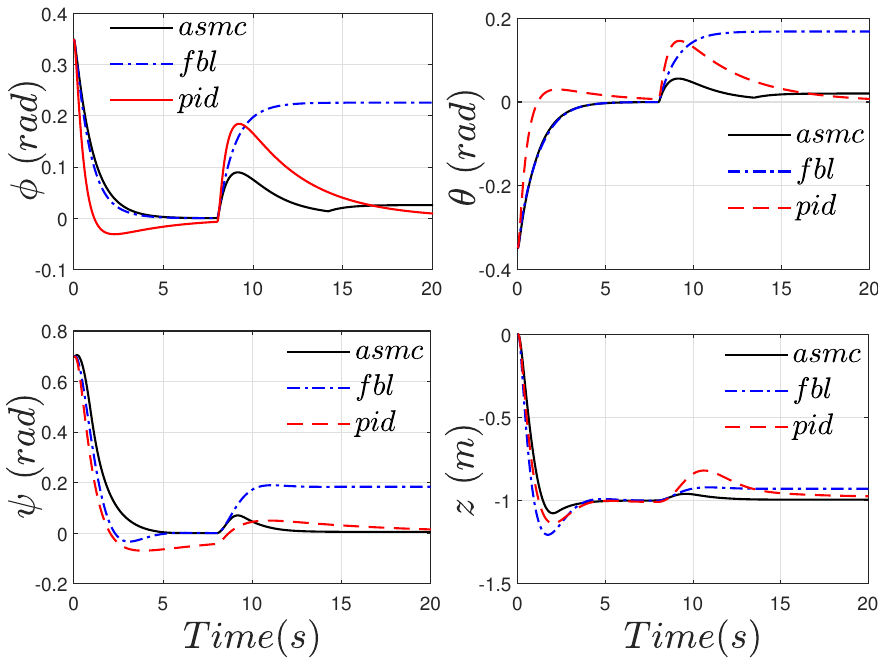
Figure 2. Regulation. Controllers comparison: adaptive sliding mode control (asmc), feedback linearization (fbl), and proportional integral derivative with gravity compensation control